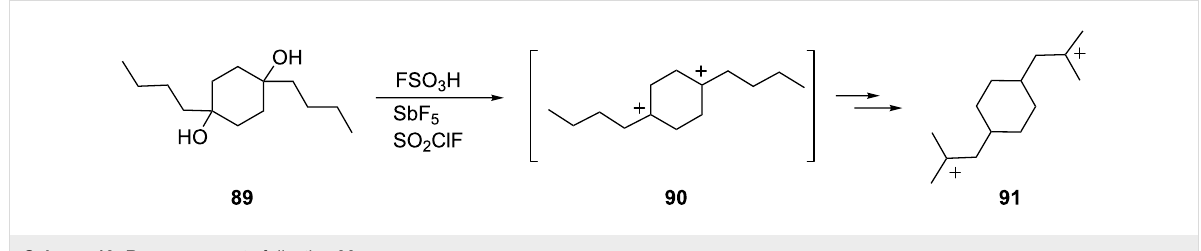
Scheme 19: Rearrangement of dication 90 .